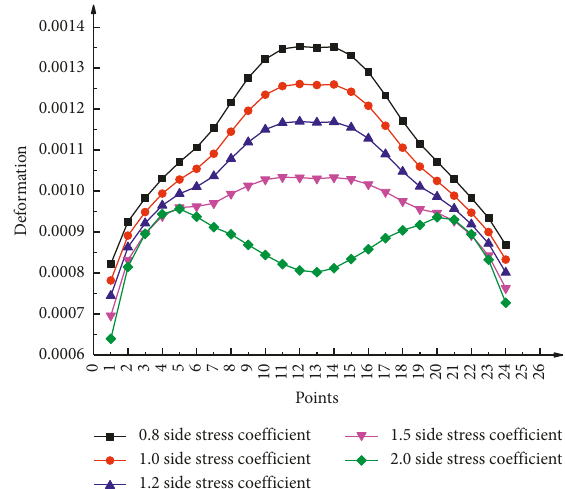
Figure 6: The deformation of various side stress coefficients. The black broken line, red broken line, blue broken line, pink broken line, and green line represent the deformation of 0.8, 1.0, 1.2, 1.5, and 2 side stress coefficients,